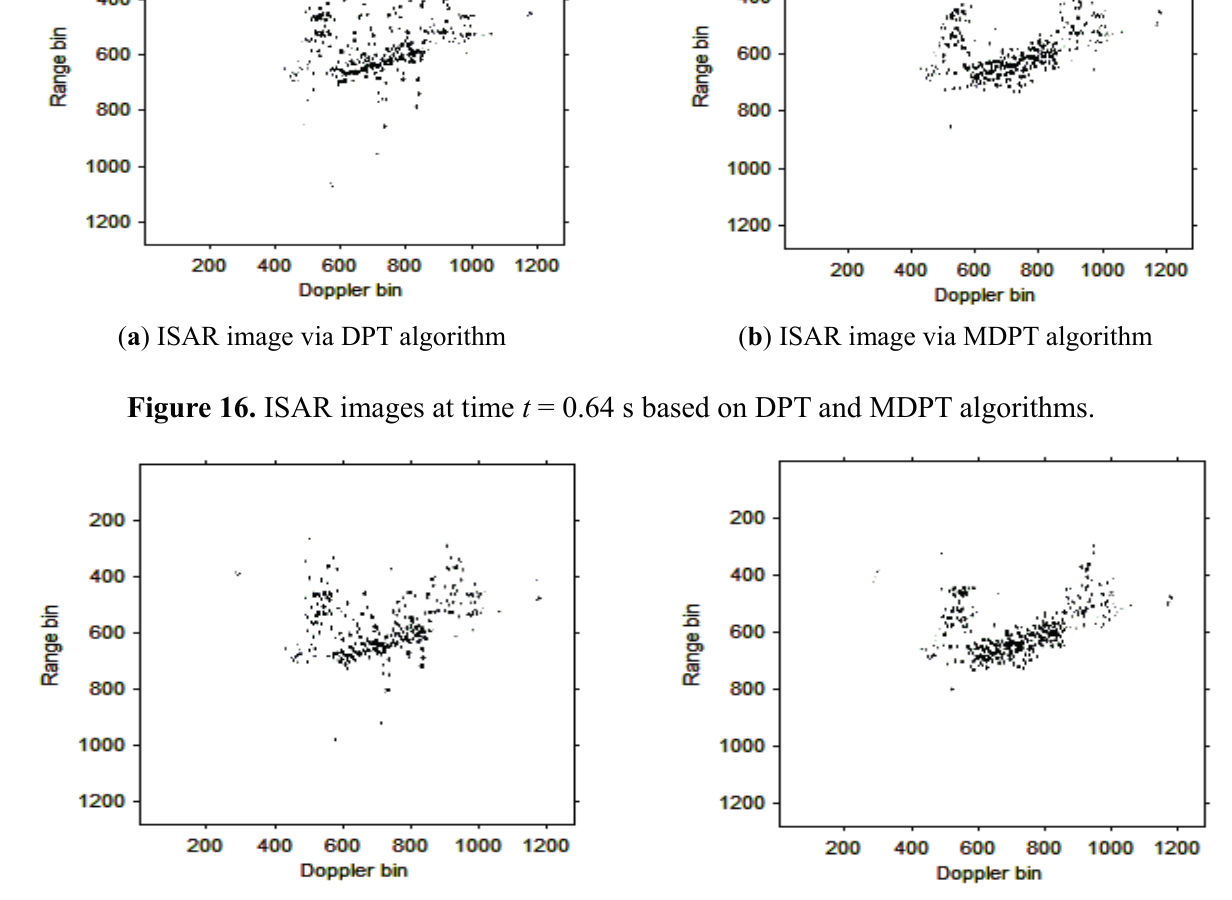
Figure 17. ISAR images at time t = 0.80 s based on DPT and MDPT